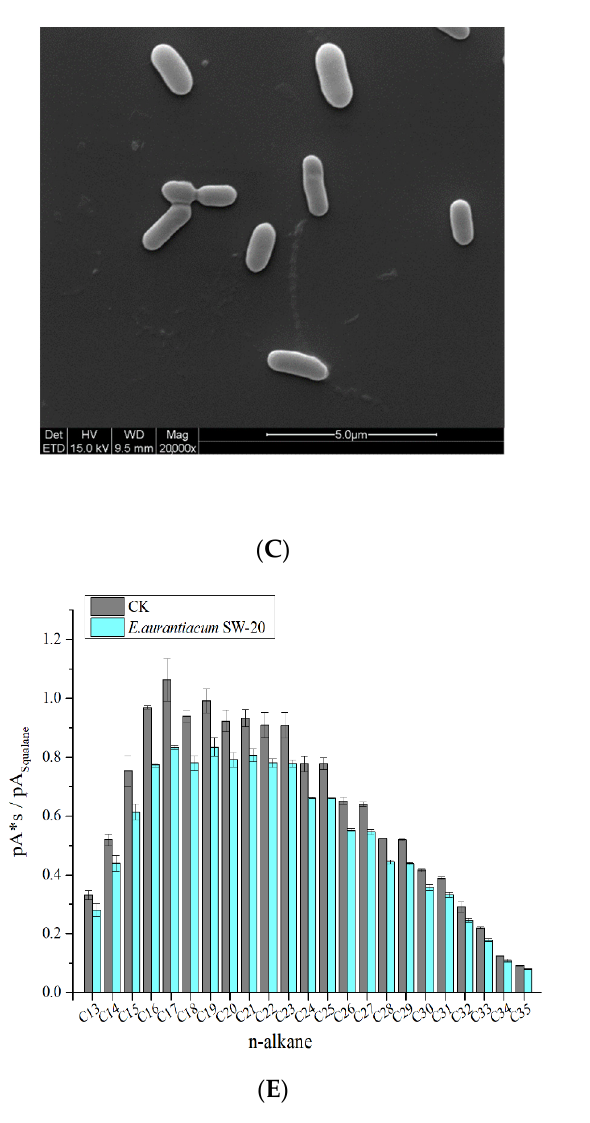
Figure 3. Characteristics of E. aurantiacum SW-20 ( A ) Colony morphology of the strain in 5% LB solid medium ( B ) SEM imagines at 0% NaCl ( C ) SEM imagines at 8% NaCl ( D ) Growth curve on different content of NaCl ( E ) Degradation diagram of n-alkanes in crude oil.